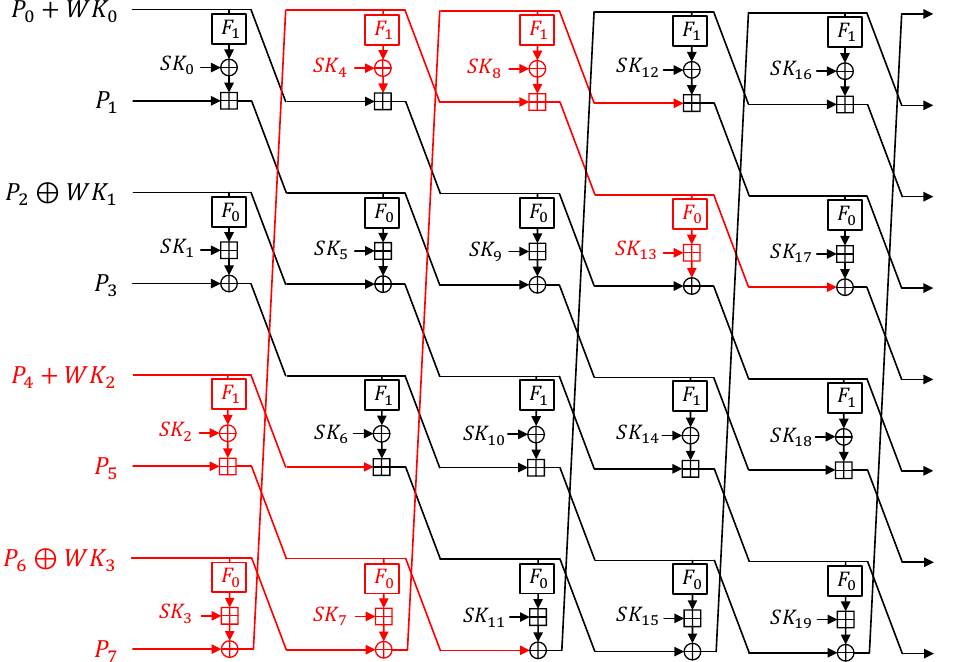
Figure 11. Rounds that can be efficiently progressed by a fixed nonce in